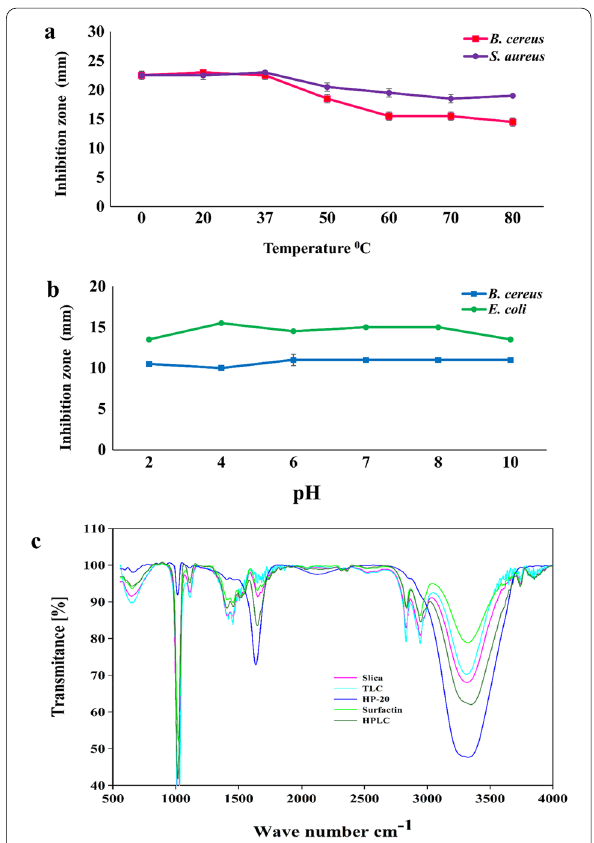
Fig. 6 Effect of a Temperature and b pH on antimicrobial activity of surfactin lipopeptide against B. cereus NCIM 2703 (pink and blue respectively) and S. aureus NCIM 2654 (violet) and E.coli NCIM 2832 (green). c Fourier transform infrared spectroscopy of B. velezensis SK lipopeptide extracted by HP-20 (blue) and purified by TLC (cyan), HPLC (forest green), and Silica gel chromatography